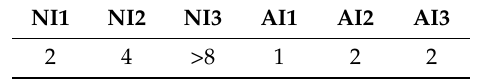
Table 5. Number of impact events for rupture.